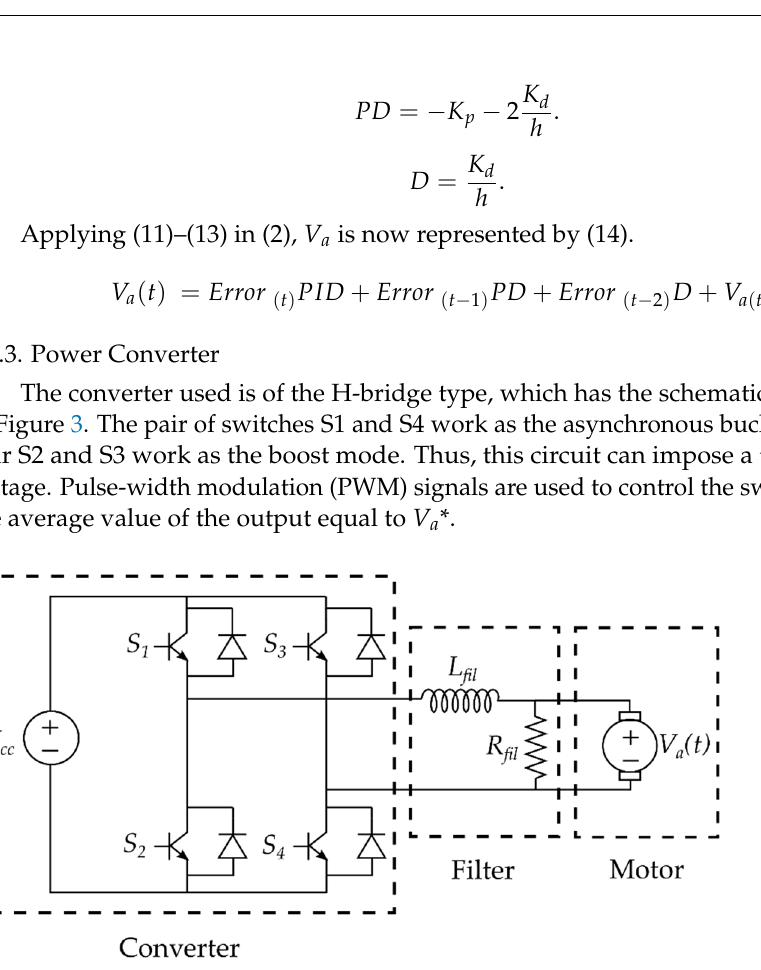
Figure 3. Schematic of the modeled dynamic